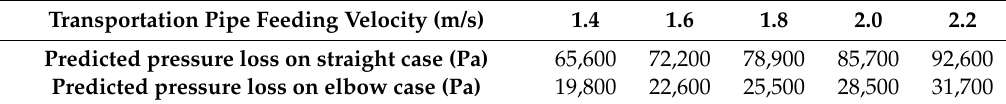
Table 2. Predicted pipe transportation pressure loss based on the CFD